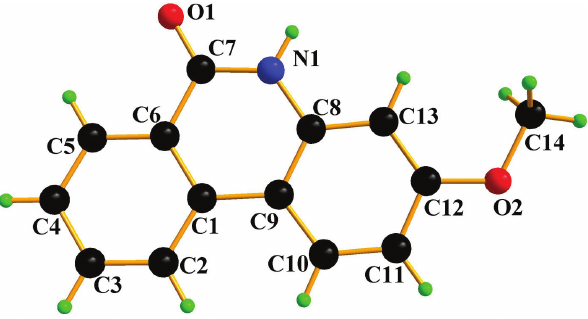
Table 1: Data collection and handling.